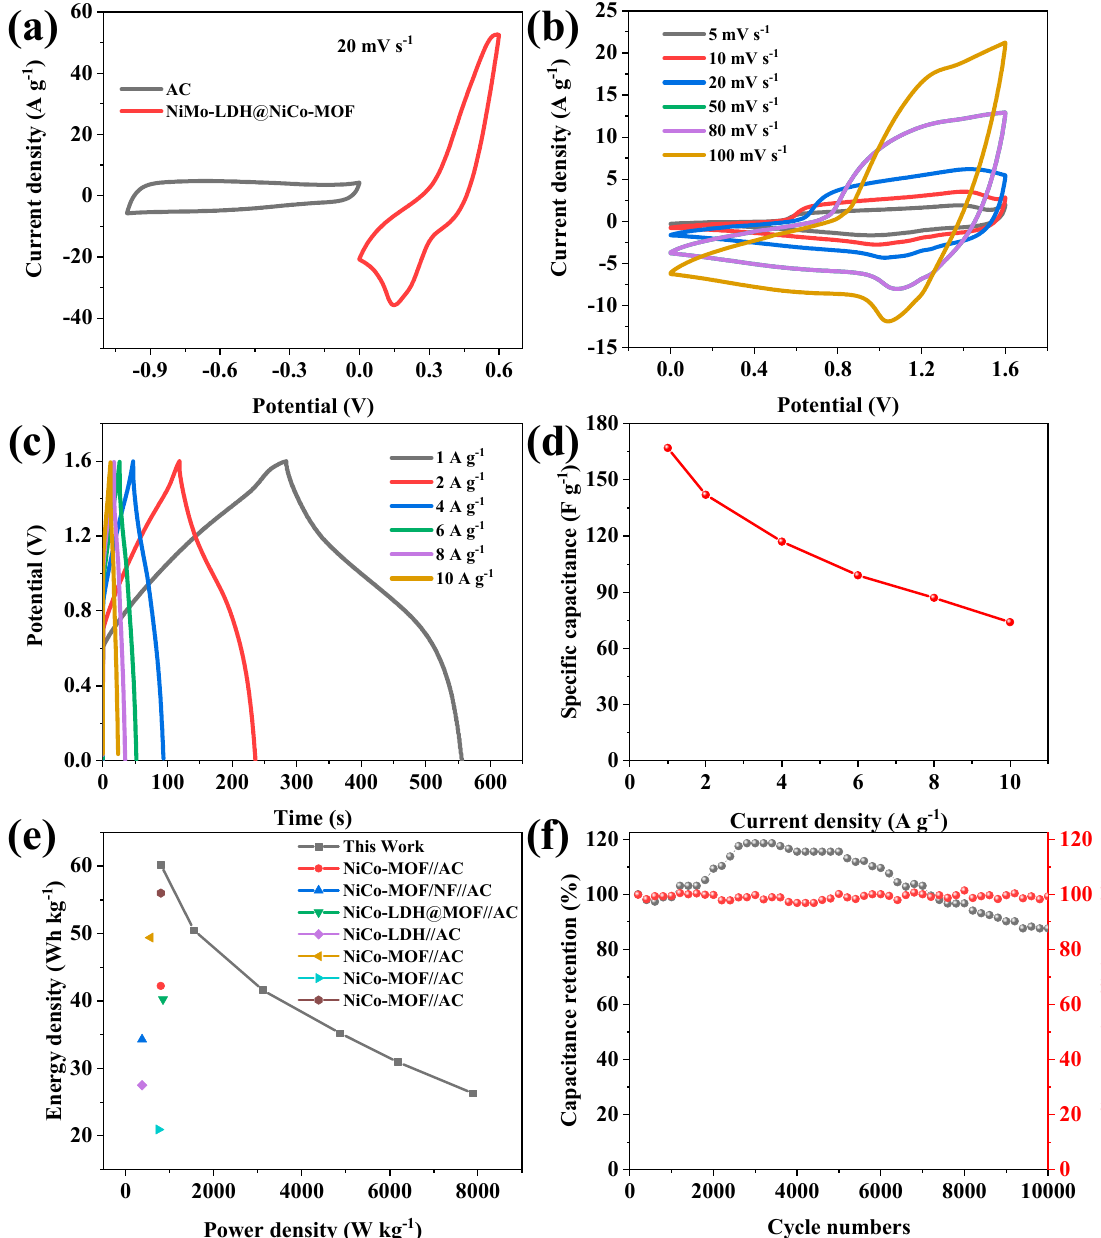
Figure 10. ( a ) CV curves of NiMo-LDH@NiCo-MOF and AC electrodes; ( b ) CV curve of NiMo-LDH@NiCo-MOF//AC; ( c ) GCD curves of NiMo-LDH@NiCo-MOF//AC; ( d ) specific capacitance of NiMo-LDH@NiCo-MOF//AC; ( e ) Ragone plot; ( f ) cyclic stability and coulomb effect diagram at 10 A g -1 .